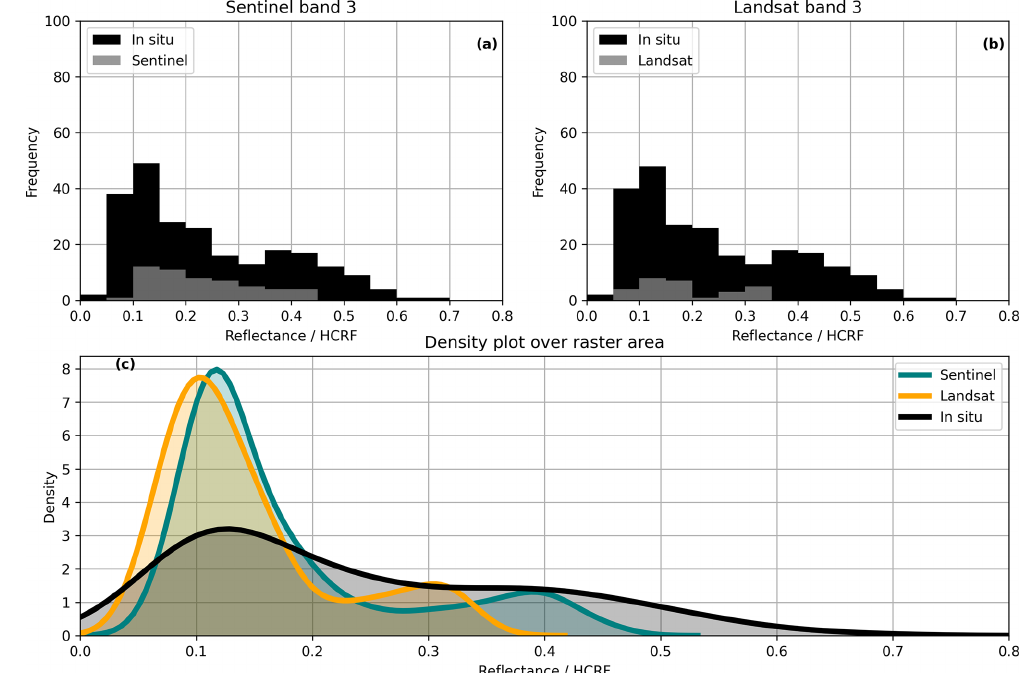
Figure 10. The histograms in panels (a, b) show the frequency of occurrence of the band-3 mean values of the ground measurements per reflectance bin. Bin width: 0.05. Overlaid in grey are the histograms of the corresponding satellite pixel values. Panel (c) shows density plots of the Sentinel and Landsat band-3 surface reflectance rasters over the study area (smallest possible rectangle containing all ground measurements), with the density of the in situ HCRFs for comparison. Table 4. Comparison of in situ and satellite data by the standard deviation (SD) of the difference between in situ HCRF and satellite surface reflectance. Values are grouped by number of pixels that buffered in situ measurements overlap. Sentinel